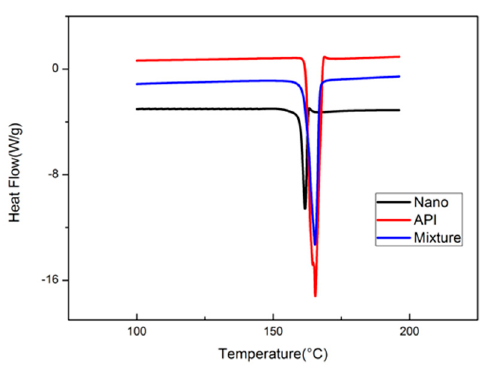
Figure 5. Reversible heat flow of the drug substances and nanosuspension variants using DSC. Abbreviations: Nano, MDZ nanocrystals; API, MDZ coarse powder; Mixture, physical mixture; Blank, blank excipients.